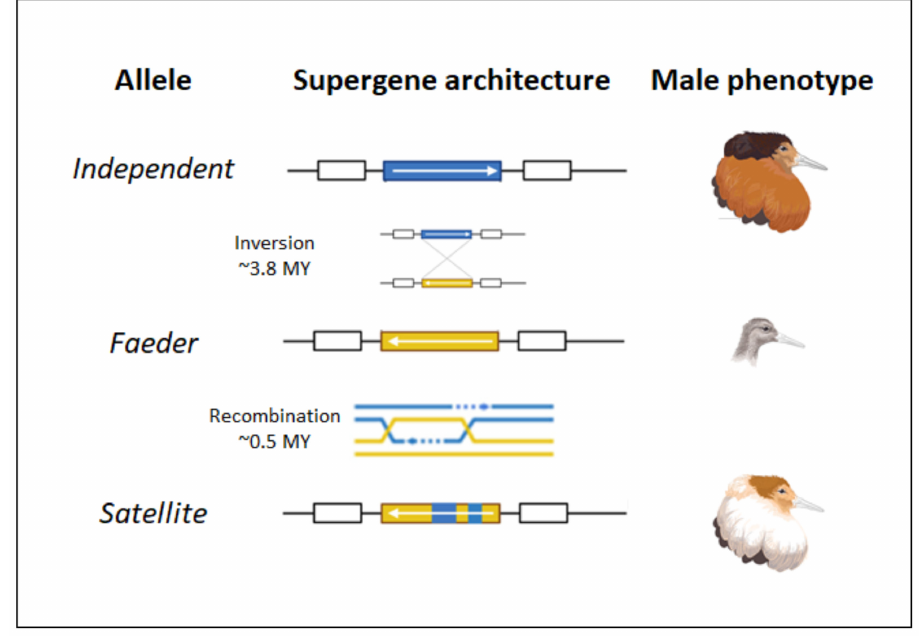
Figure 3. Schematic overview of the evolution of the ruff supergene that regulates the male pheno- types. The inversion of the ruff supergene that occurred ca. 3.8 million years ago on chromosome 11 gave rise to the sneaker phenotype. An exceptional viable recombination event between the Independent and Faeder allele ( ca. 500.000 years ago) produced the Satellite allele that gives rise to the satellite phenotype. Modified from [53]. Male ruff head profiles from [60], with